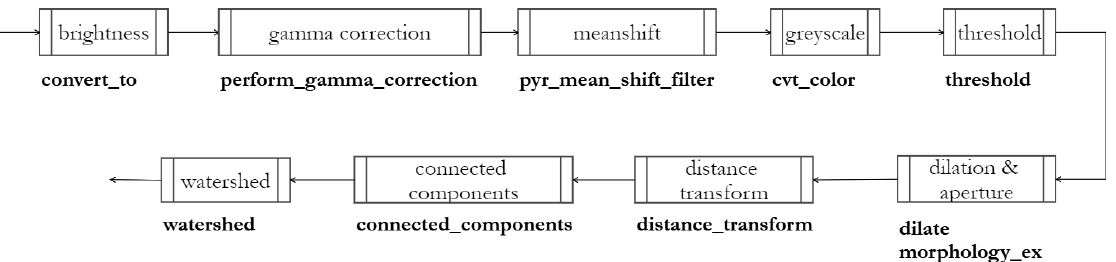
Figure 11. Cell extraction pipeline with methods—see “detect()” in Appendix B.